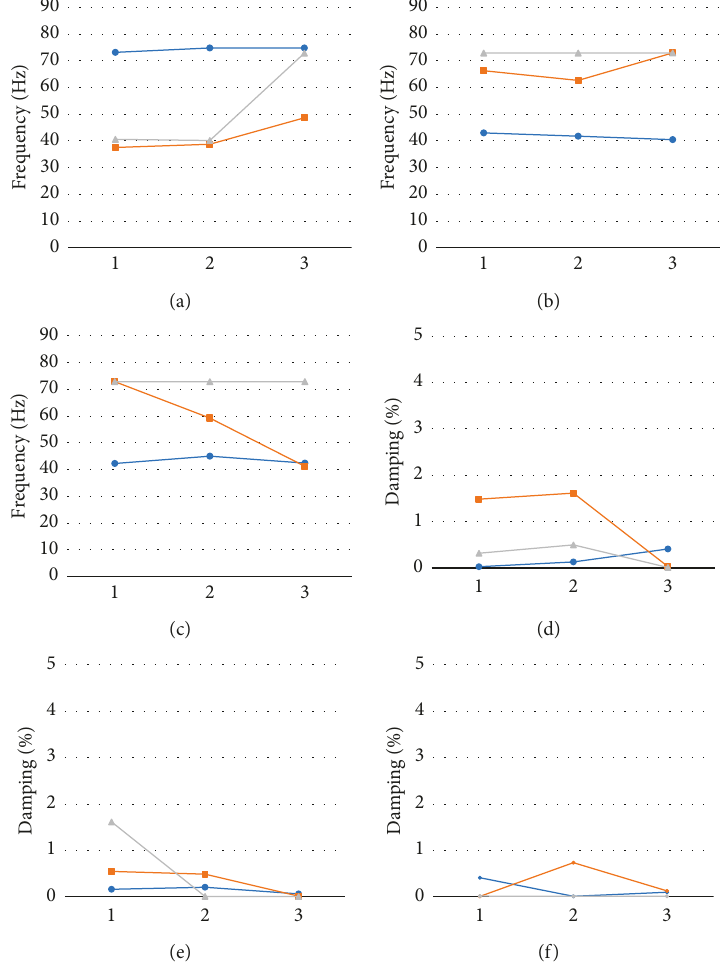
Figure 11: 2nd bending modal shape: comparison of dynamic parameters.